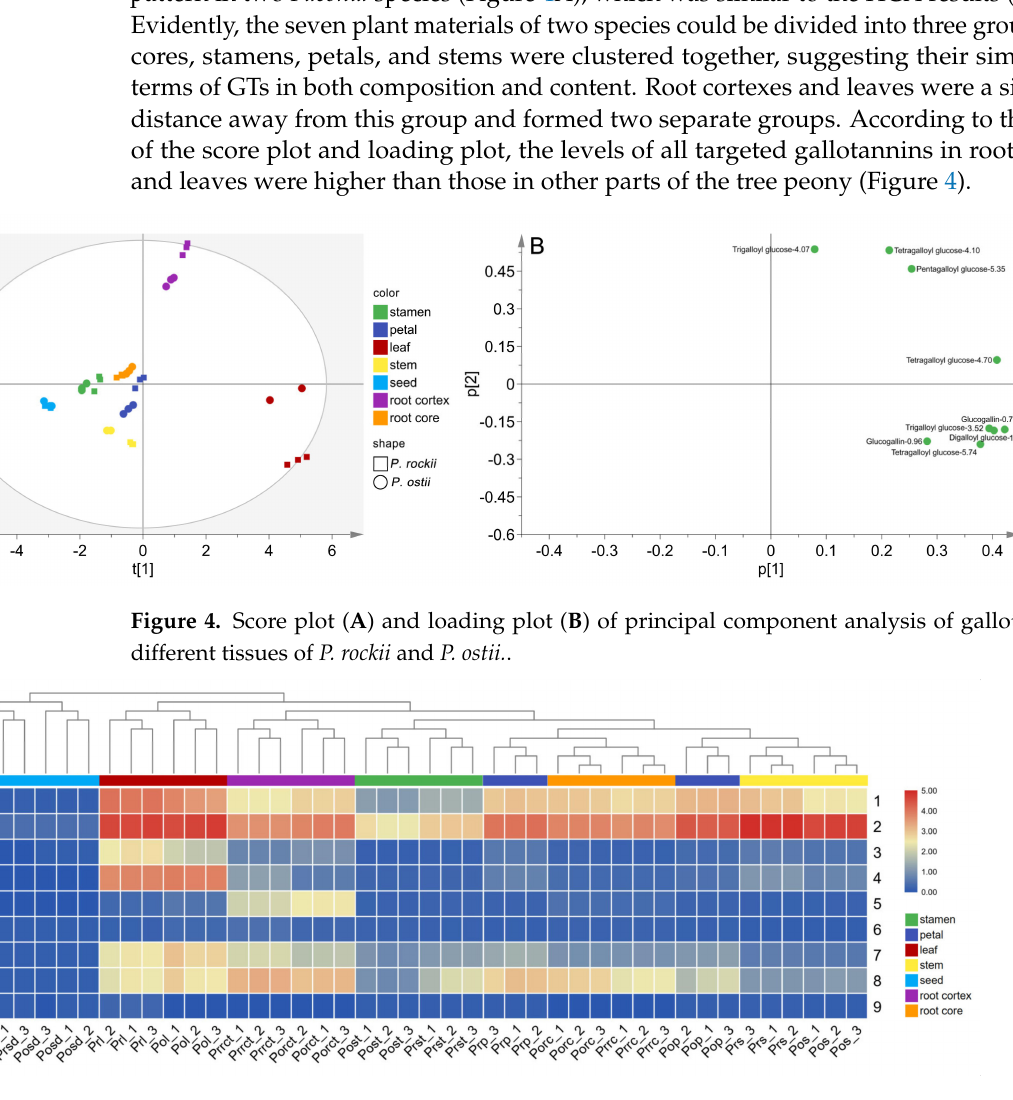
Figure 5. Heatmap of gallotannins in different tissues of P. rockii and P. ostii